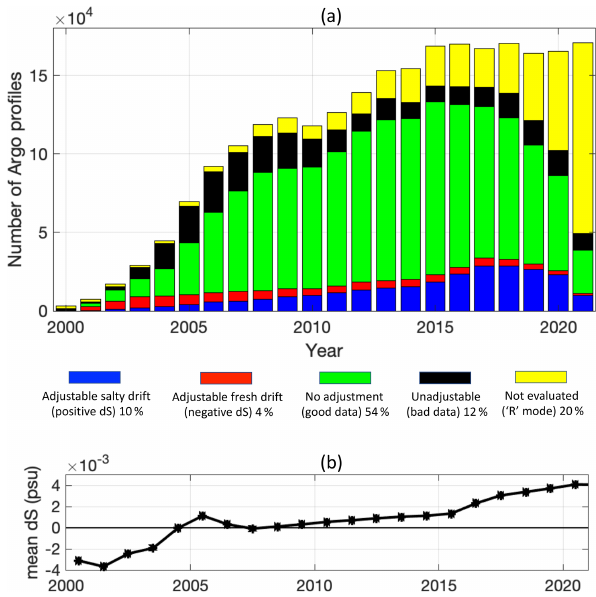
Figure 1. (a) Temporal distribution of Argo salinity delayed-mode evaluation. Values are from April 2022. (b) Annual average of all delayed-mode salinity adjustments, which is an estimate of the ad- justable bias in the raw Argo salinity data.